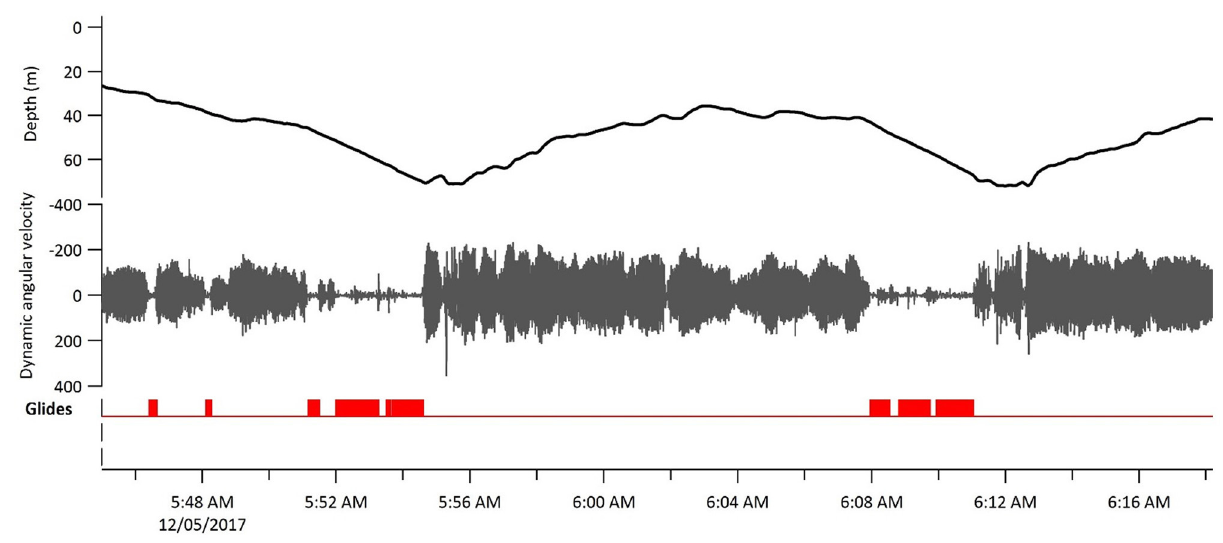
( Figure 2 ). For other summary statistics of vertical movements, see Table 3